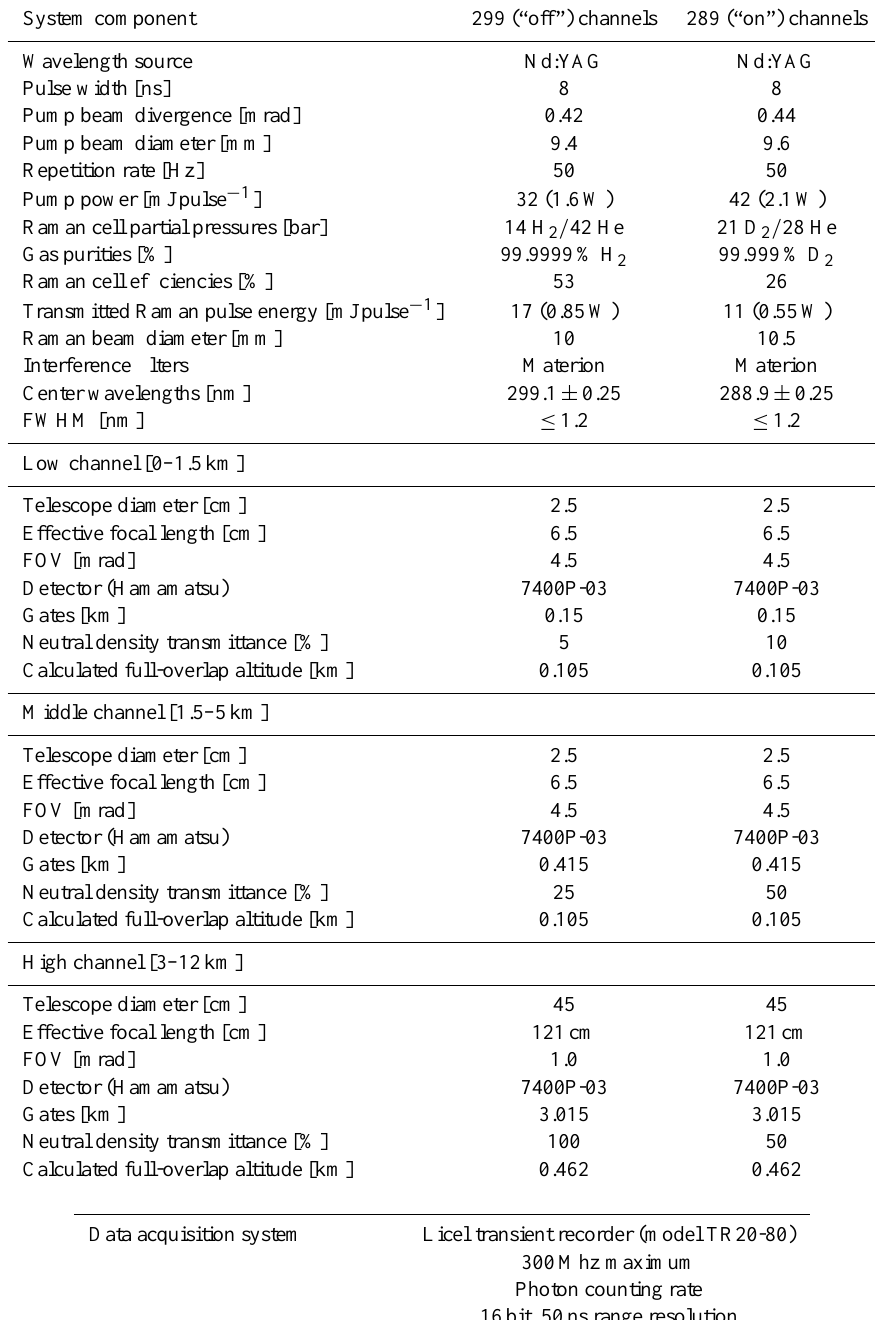
Table 1. Hardware description for the GSFC TROPOZ DIAL system for the transmitter, receiver components, and the data acquisition